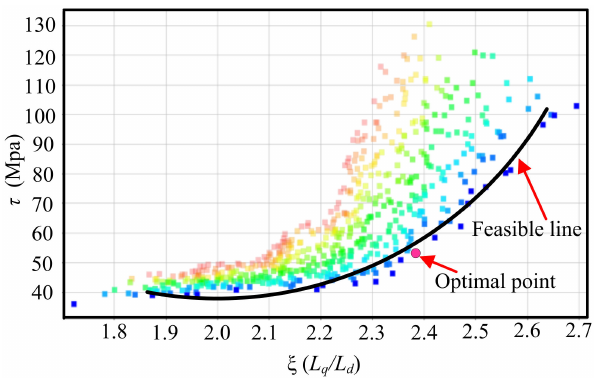
Figure 7. The tradeo ff between the maximum stress and the rotor saliency.